Question: Sum up the contents of this chart in one sentence.
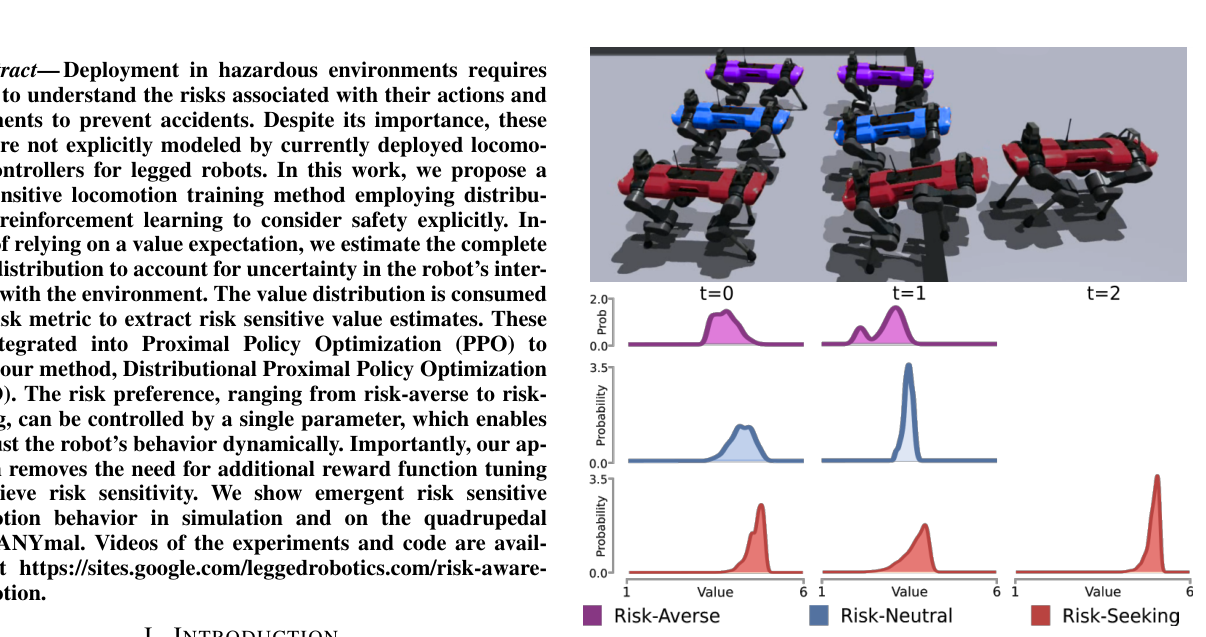
Answer: Our robot learns to adapt its locomotion behavior in risky situations. When commanded to walk up a large step, the risk-averse policy (■) refuses while the risk-seeking policy (■) complies. The risk parameter, controlling the value distribution distortion, can be adapted online during deployment. Bottom: Respective risk-metric distorted value distribution per robot.